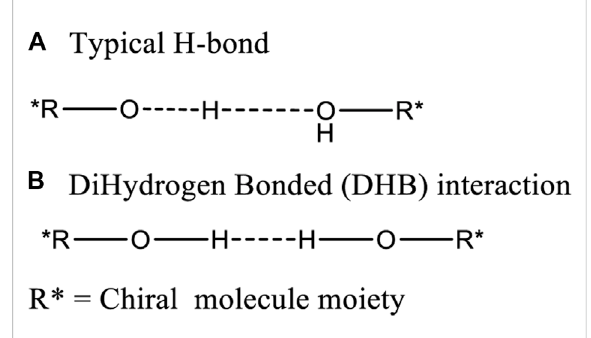
FIGURE 13 Two possible intermolecular interaction modes ( A : typical